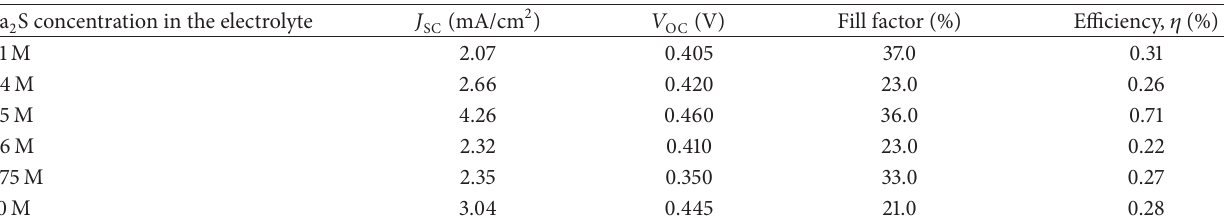
Table 2: Performance parameters of CdSe QDSSCs with electrolytes having various amounts of Na solution.